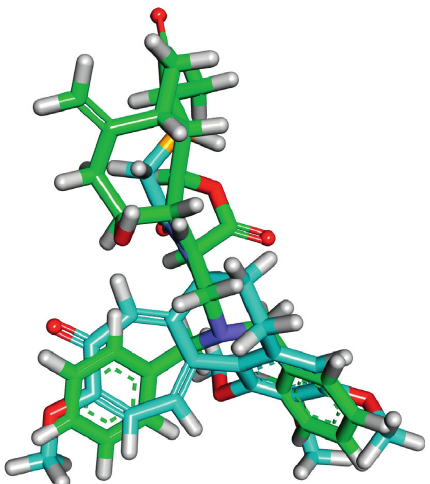
Figure 6: Flexible alignment of compound 5 (carbon atoms in green) with the colchicine (carbon atoms in